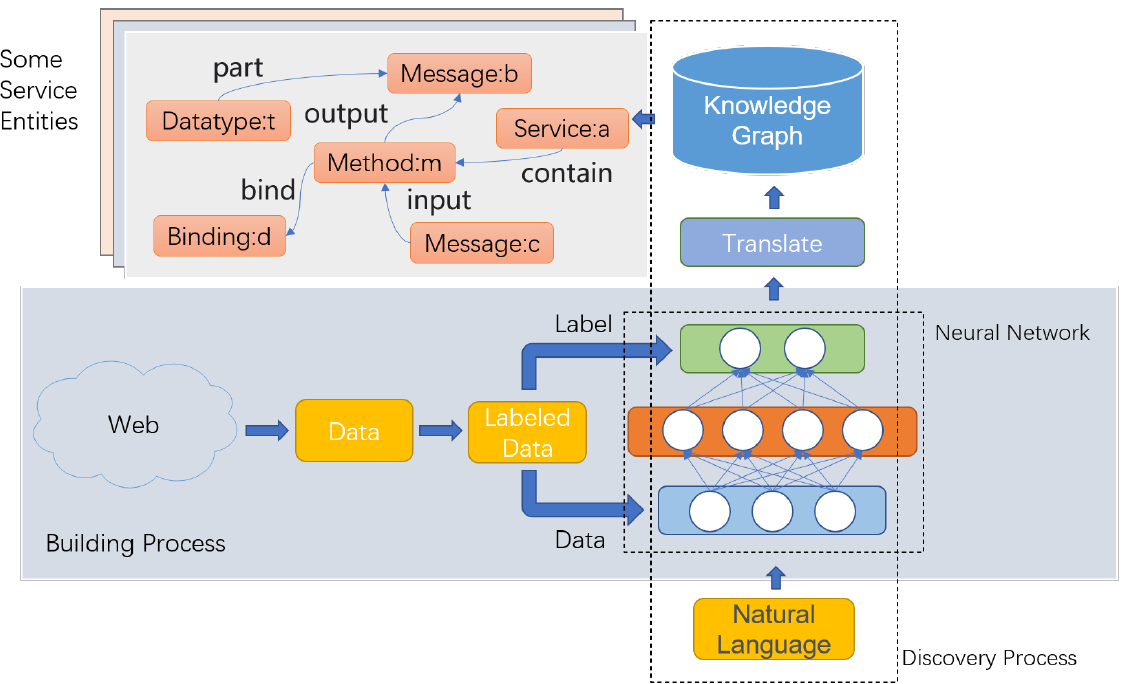
Figure 6. Process of semantic relationship expansion of the service knowledge graph. The whole process is divided into two parts: building and discovery. Build is the process used when expanding the semantics. The main task is to train the neural network. The discovery process is the application of newly added semantic information in the graph when doing service discovery tasks.